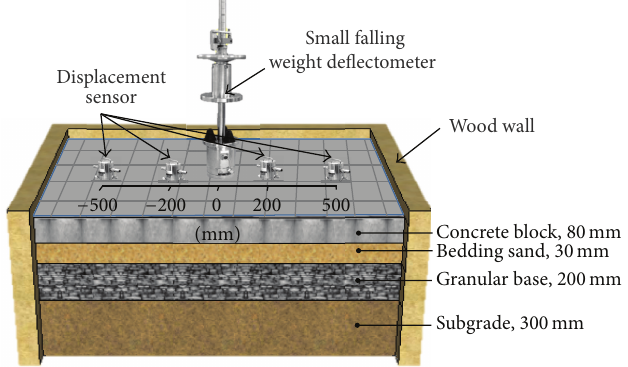
Figure 1: Specification of dynamic laboratory loading test.